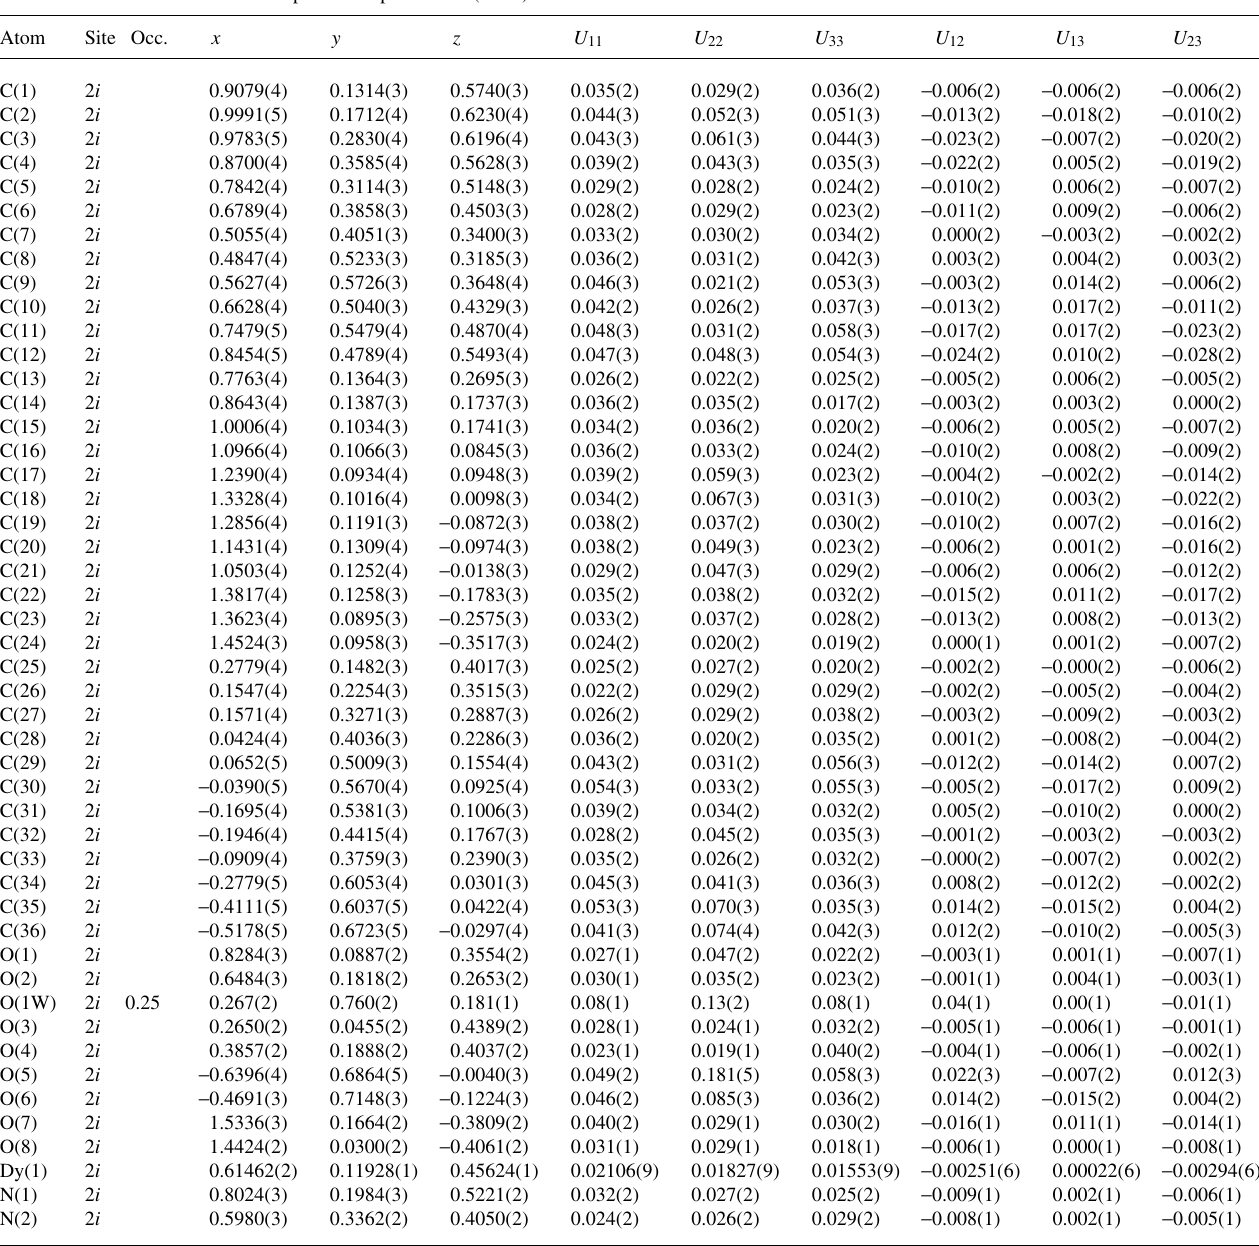
Table 3. Atomic coordinates and displacement parameters (in Å 2 ) .